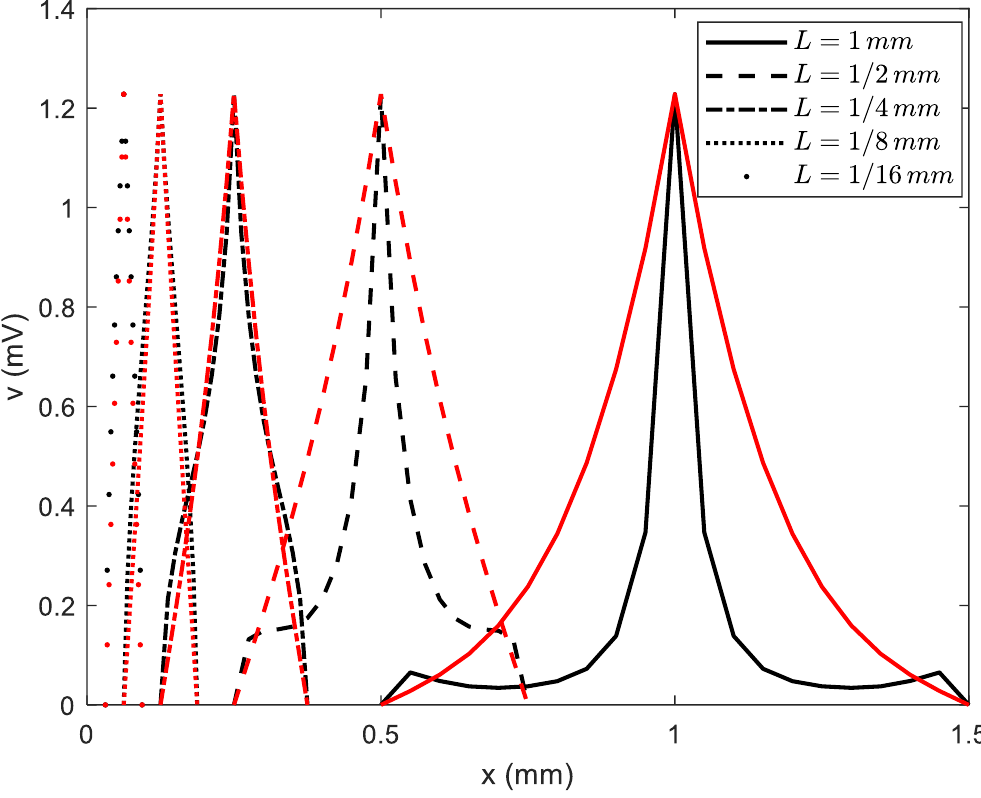
Figure 10. Profiles of 𝒗(𝒙,𝒕) for 𝜶 = 𝟎. 𝟔𝟓 (black) and 𝜶 = 𝟏 (red) at 𝒕 = 𝟎. 𝟏 𝒎𝒔 and for various values of the internodal length 𝑳 . The shapes for the two values of 𝜶 are identical for shorter internodal